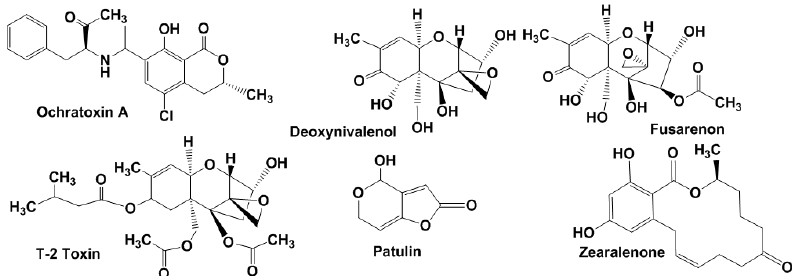
Figure 2. Chemical structures of ochratoxin A, patulin, zearalenone and some trichothecene mycotoxins.